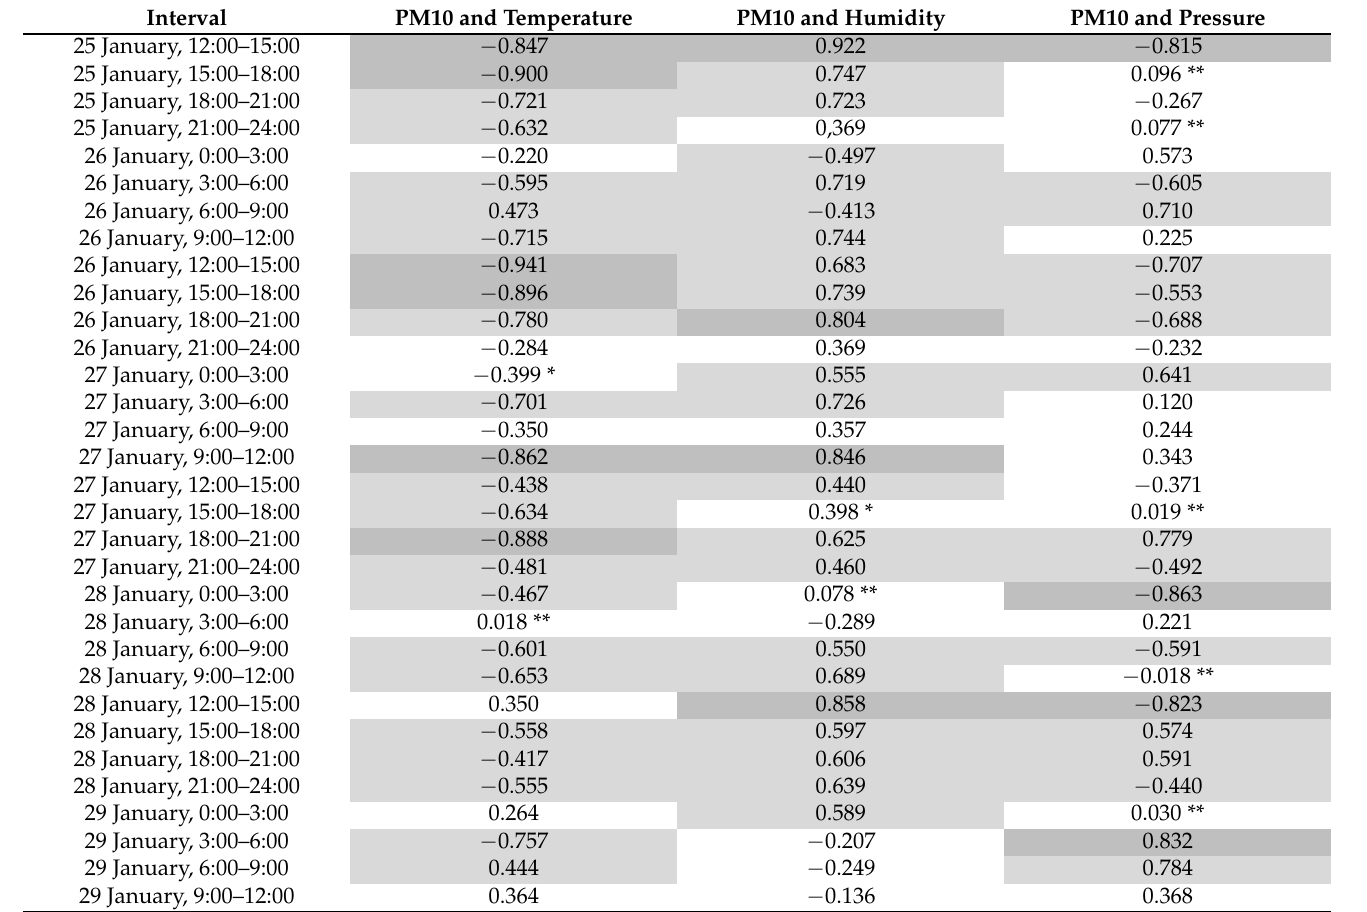
Table 8. Correlation between PM10 and temperature, humidity, pressure: 3-h